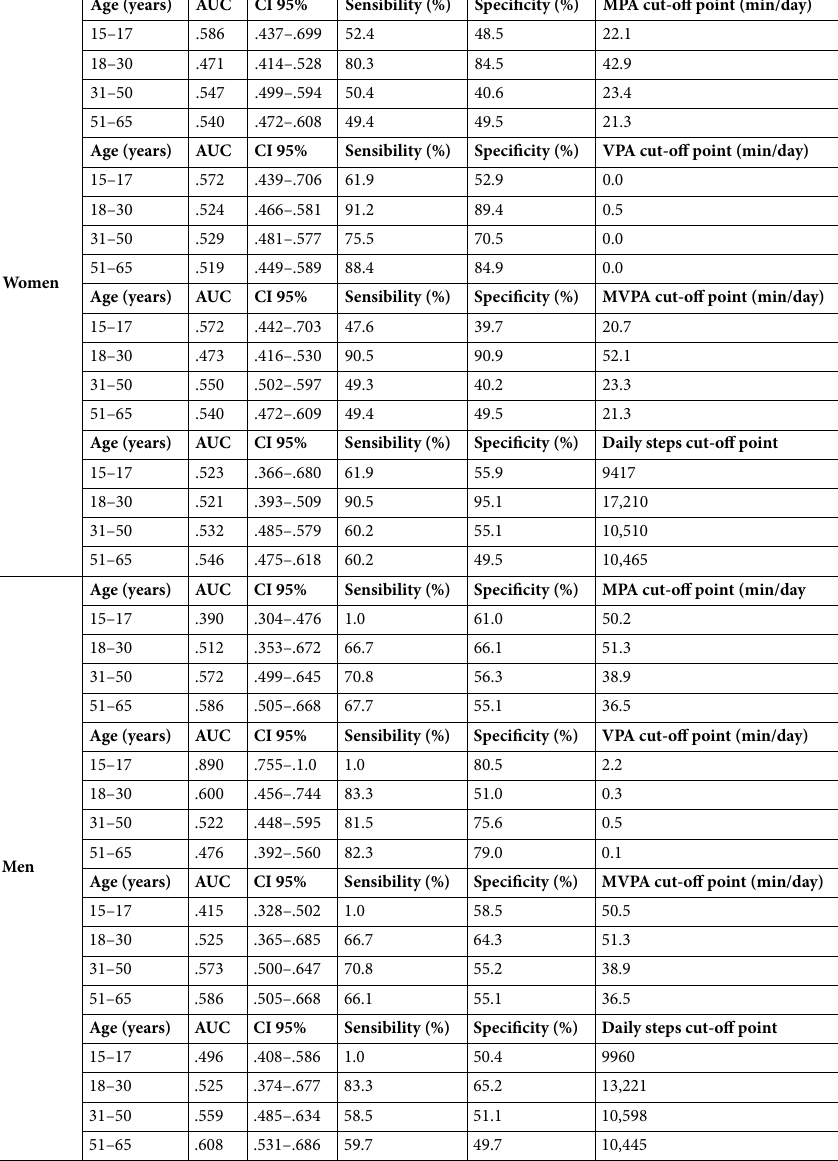
Table 5. Physical activity cut-off points (min/day) and number of steps according to sex and age categories in relation to WHR. AUC, area under the curve; CI 95%, confidence interval; MPA, moderate physical activity; VPA, vigorous physical activity; MVPA, moderate-to-vigorous physical